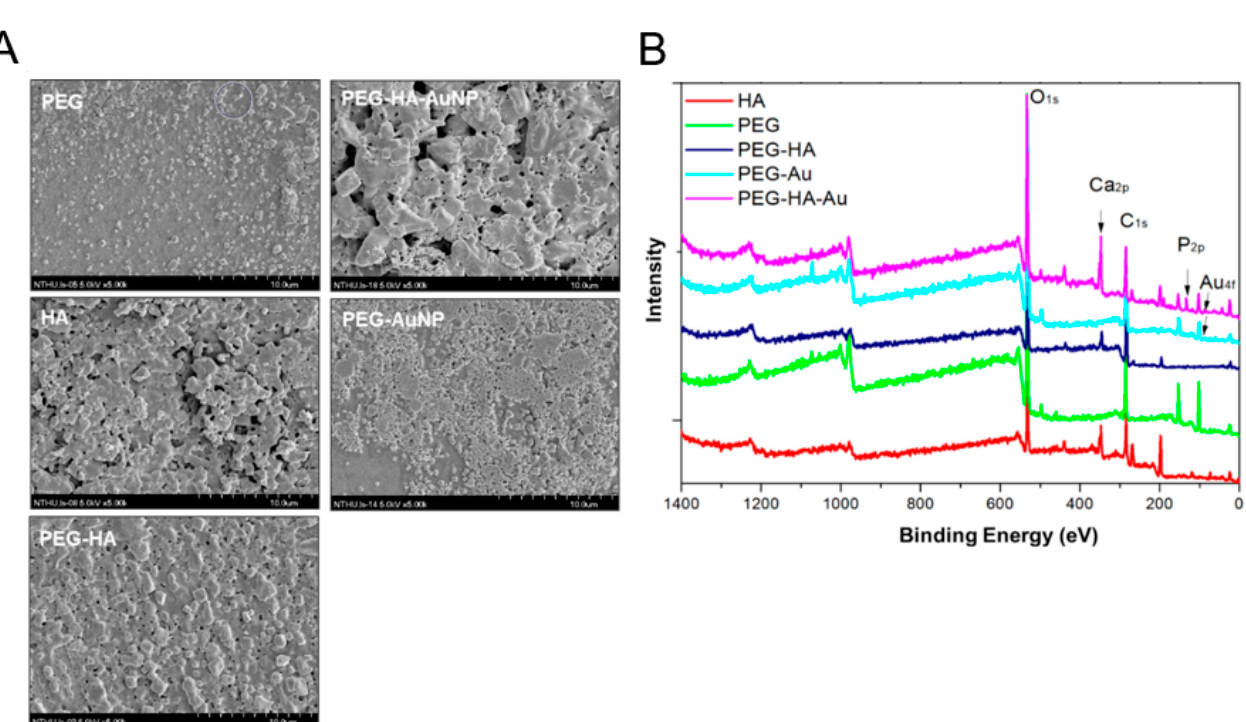
Figure 3. Material characterization. ( A ) SEM analysis of different materials. ( B ) Wide-scan spectra of PEG and PEG composites by XPS analysis.